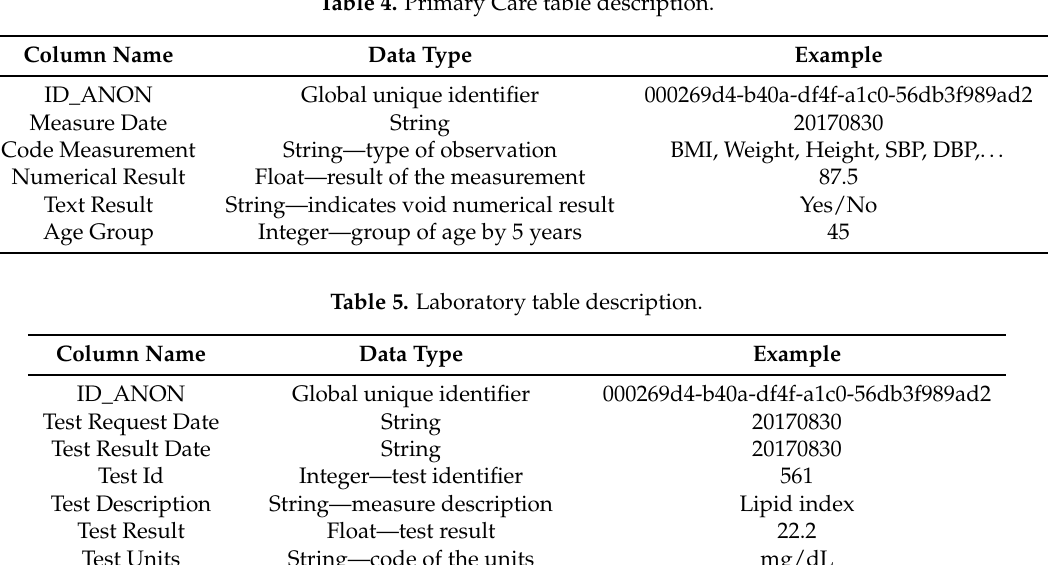
Table 4. Primary Care table description.